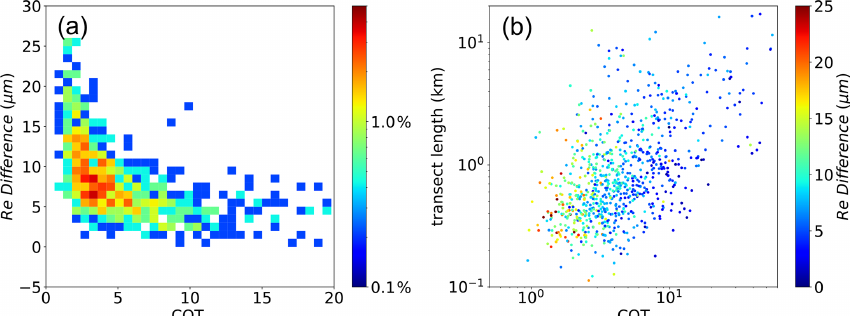
Figure 8. (a) Density plot of the cloud element mean R e difference (bi-spectral – polarimetric R e ) vs. mean COT. (b) Scatterplot of the R e difference (color) vs. transect length and COT using cloud element means.